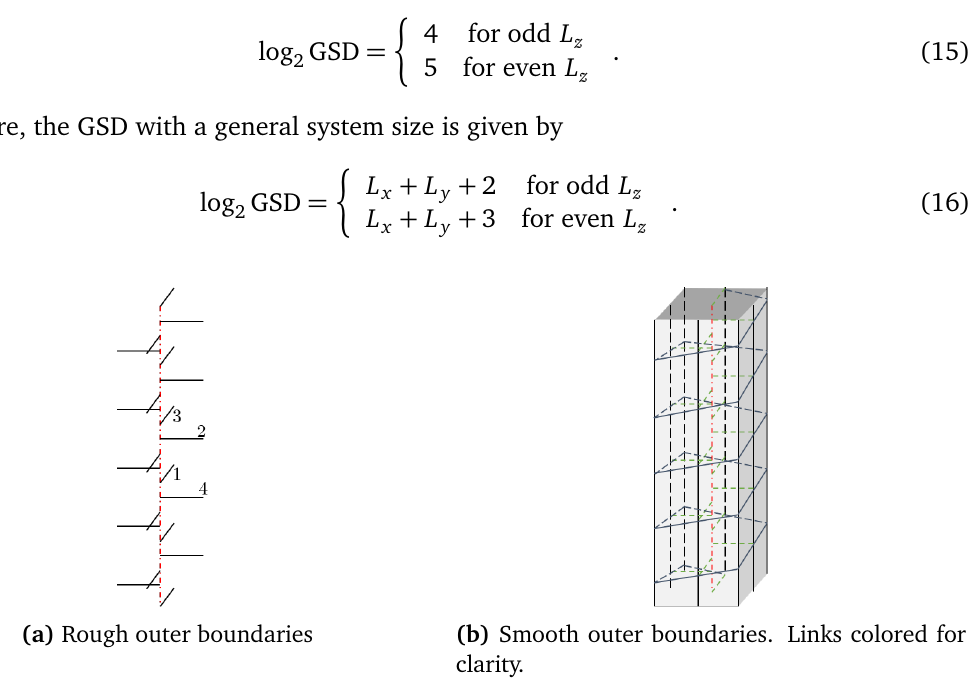
Figure 24: The minimal structure of a rough screw dislocation. The dislocation line is colored